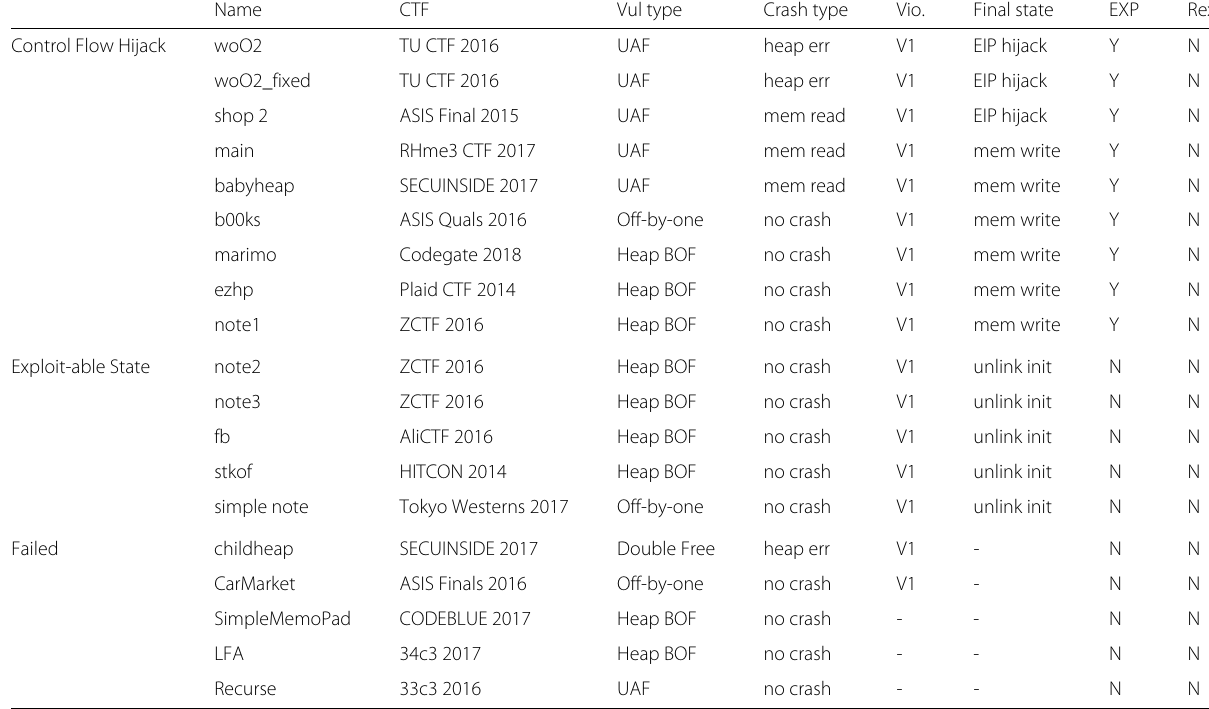
Table 1 List of CTF pwn programs evaluated with Revery